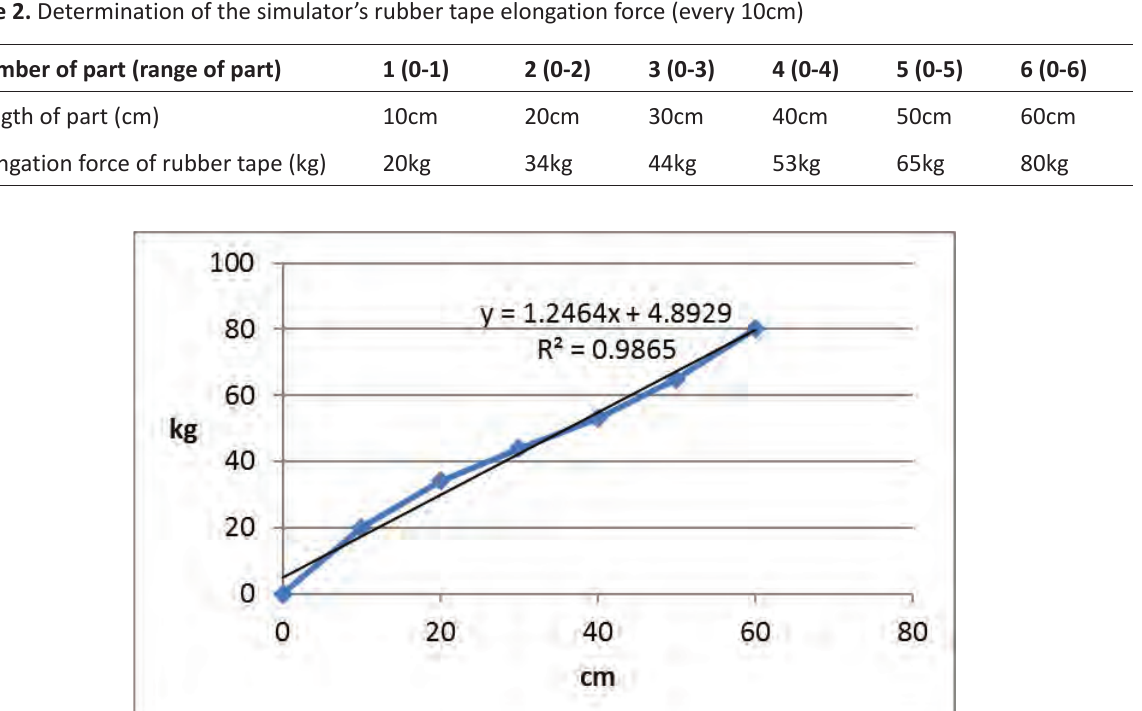
Figure 1. Regression between the force of elongation and the length of the